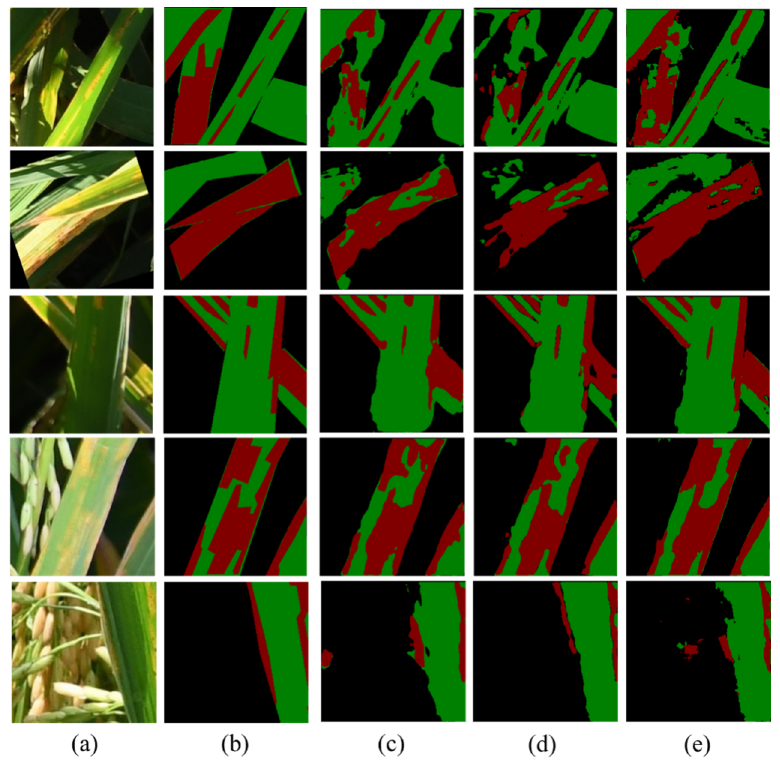
Figure 11. Comparison of prediction results for different models: ( a ) image ( b ) label; ( c ) UNet segmentation result; ( d ) DeepLabV3+ segmentation result; and ( e ) BLSNet segmentation result. Each